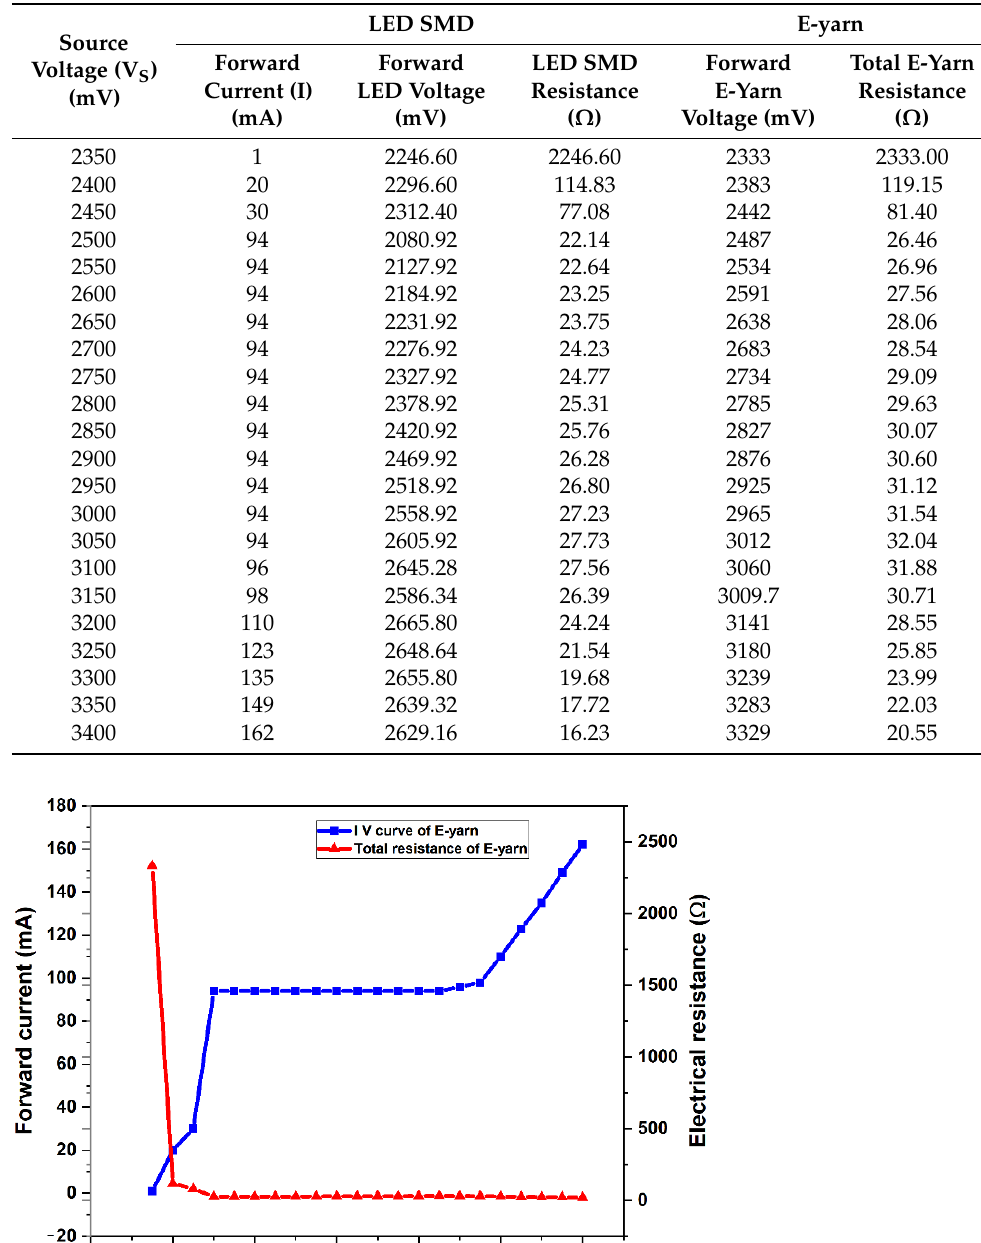
Table 5. Total electrical resistance of a LED circuit with specific forward voltages (2.35–3.4V).